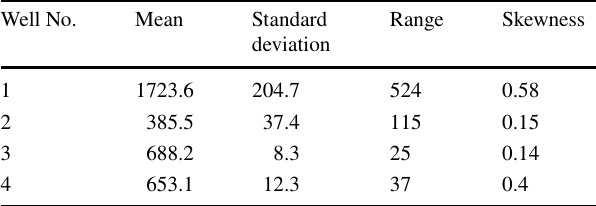
Table 1 The statistical characteristics of TDS data in observation wells Well No. Mean Standard deviation